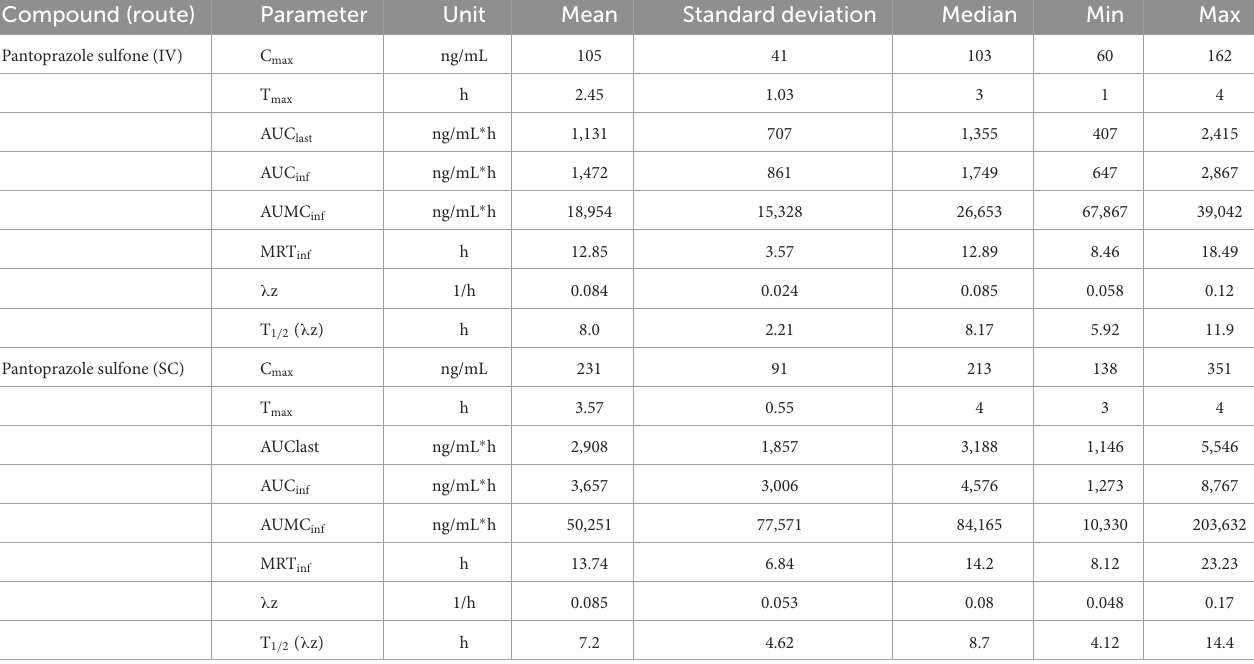
TABLE 3 Day 1 pharmacokinetic parameters of pantoprazole sulfone after intravenous (IV) and subcutaneous (SC) administration of pantoprazole sodium in calves. Compound (route) Parameter Pantoprazole sulfone (IV)